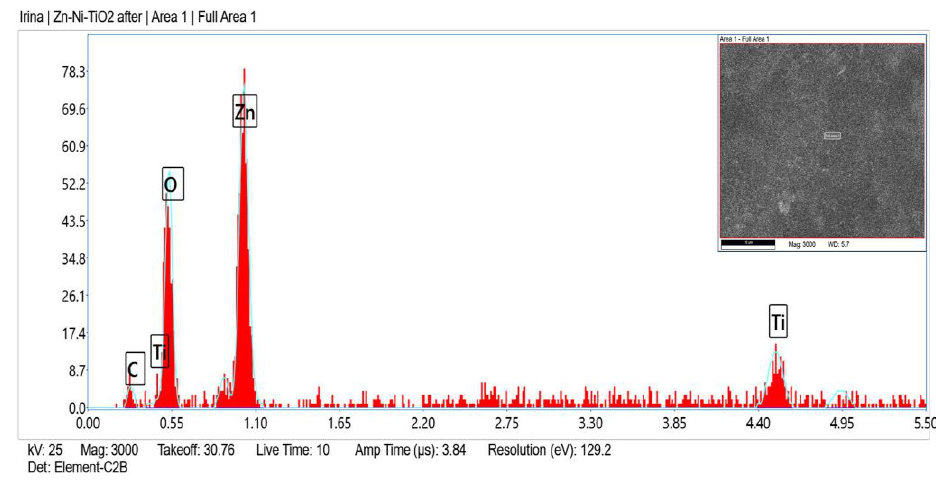
Figure 3. EDX spectrum of System A after corrosive attack.